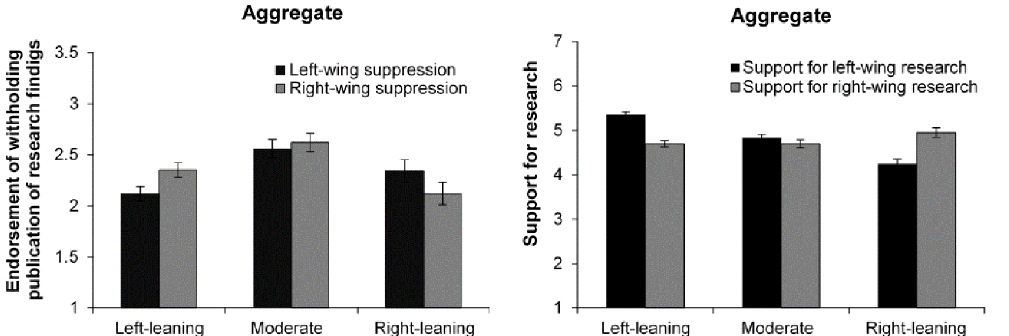
Figure 2. Aggregate scores on the research suppression and support for science measures across the three studies as a function of measure type (left vs. right-wing) and ideology (left-leaning vs. right-leaning vs. moderate participants). Error bars denote one standard error above and below the